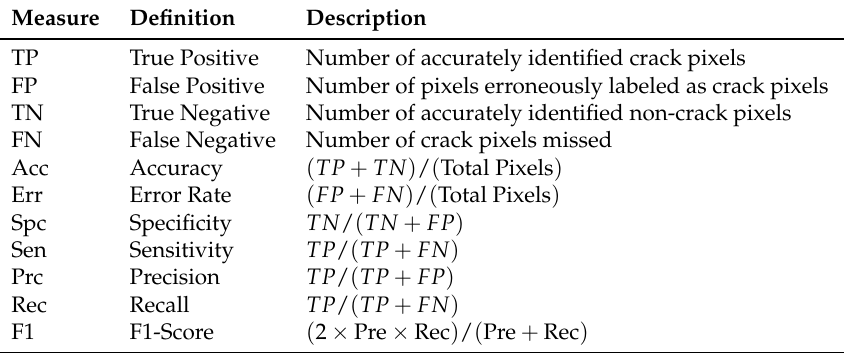
Table 4. Quantitative measures used for evaluating the results of deep network architectures. Crack pixels belong to the positive class and non-crack pixels belong to the negative class.